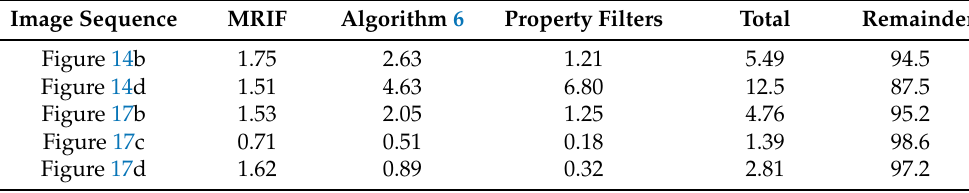
Table 1. False positive elimination rates (%) over three stages—MRIF, the luminance map-based filter (Algorithm 6) and the object property filter (with respect to the input that each filter received), and the percentage of detection events input to MRIF that were eliminated in total.